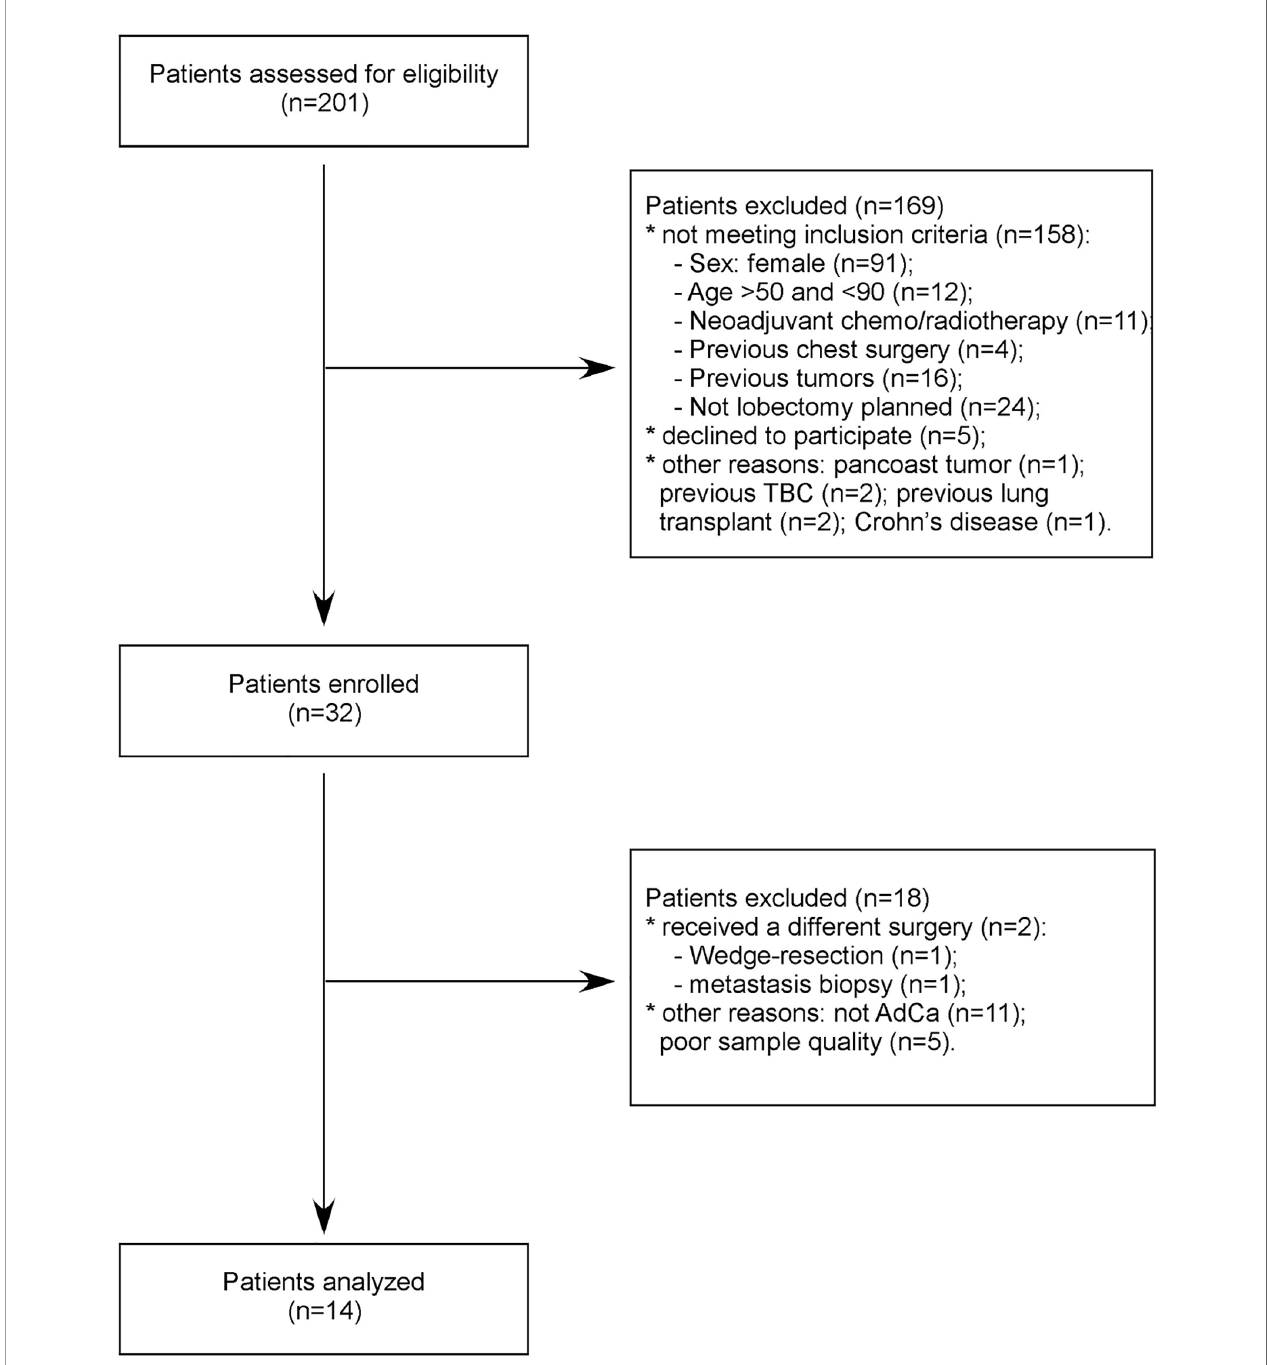
FIGURE 1 | Patients ’ selection fl